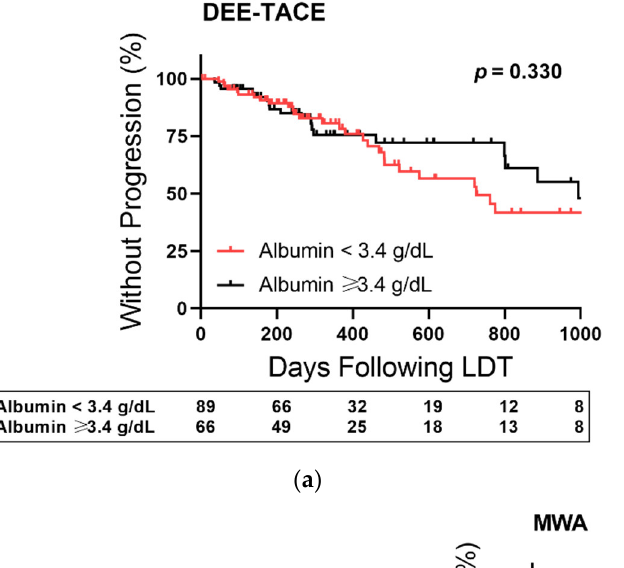
( d ) Figure 4. Albumin-Stratified Kaplan–Meier Curves of Time to Progression Based Upon HCC Bur- den and Biomarker Risk Factors following Liver-Directed Therapy (LDT). ( a ) Plot restricted to pa- tients within Milan Criteria at diagnosis. ( b ) Plot restricted to patients with T1 stage burden at di- agnosis. ( c ) Plot restricted to patients with Barcelona Clinic Liver Cancer (BCLC) Stage A disease at diagnosis. ( d ) Plot restricted to patients with a baseline alpha-fetoprotein (AFP) level < 20 ng/mL. Censored data is marked with a vertical upward dash. The total number of patients remaining in the analysis at each major x-axis time point is listed in the table below the plot. Significance was determined using the Log-Rank test. 3.5. Role of First Cycle Treatment Modality in Albumin-Based Stratification The cohort was then grouped based on first cycle LDT modality and TTP outcomes examined after stratifying for pretreatment albumin level (Figure 5). Log-rank testing of